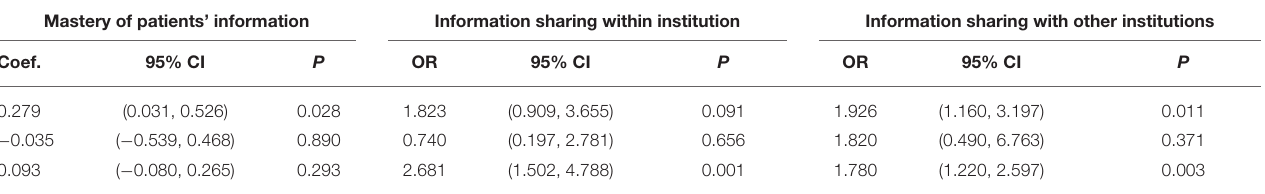
TABLE 4 | Associations between performance-based salary system incentive and care continuity and coordination among primary healthcare workers. Mastery of patients’ information Information sharing within institution